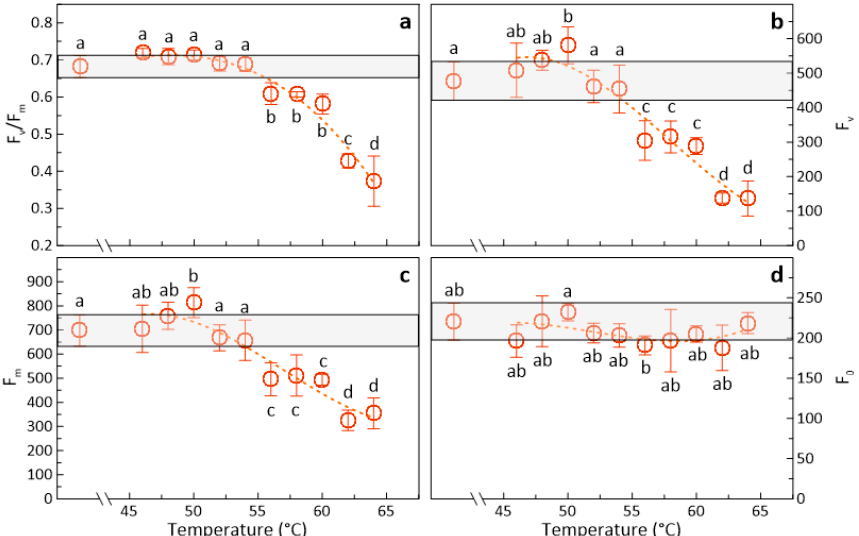
Figure 2. Average results of ( a ) the potential maximum photon yield of PSII (F v / F m ), ( b ) the variable fluorescence (F v ), ( c ) the maximum (F m ), and ( d ) the dark fluorescence signal (F 0 ) of ‘Braeburn’ apples ( ± SD; n = 3), hot-water-treated for 60 s at temperatures ranging from 46 to 64 ◦ C. The light-grey horizontal bars indicate the standard deviation of results of the respective controls on day one of the experiment, while the dotted lines indicate respective polynomial fits. Different superscripts indicate significant differences between means (Duncan’s test, p < 0.05).